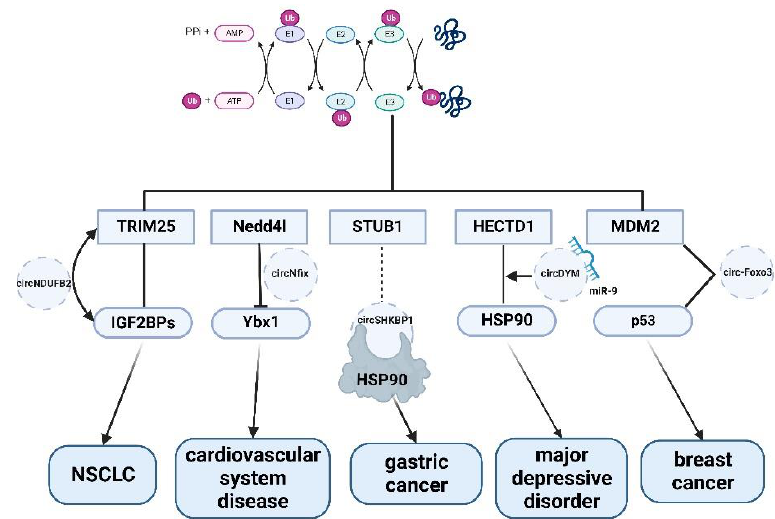
Figure 1. The mechanism of circRNA in ubiquitin signaling pathways.